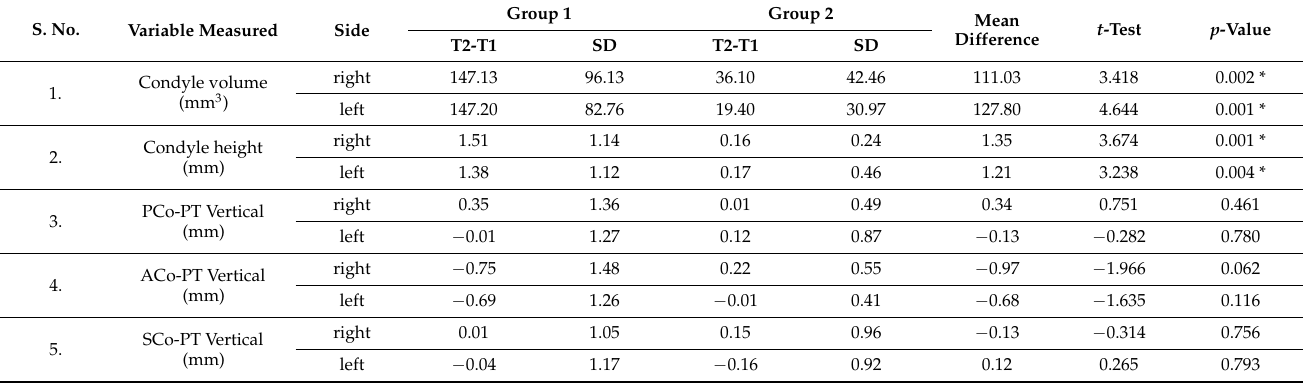
Table 4. Inter-group comparison between Group 1 and Group 2 for effective treatment changes in condyle. S. No.